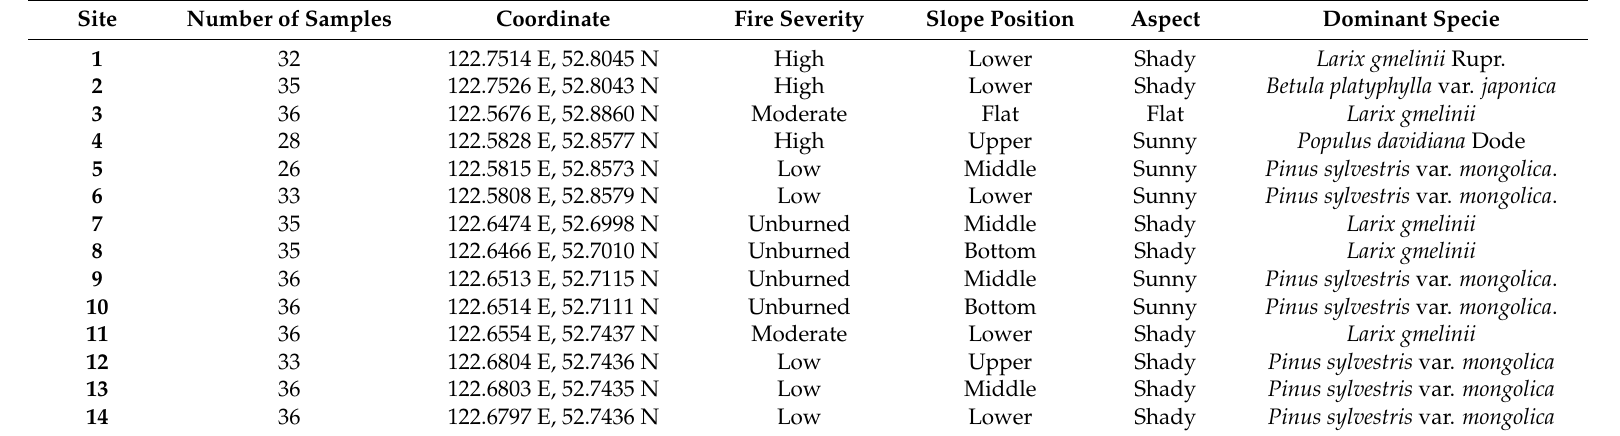
Table 1. Details of the selected sampling